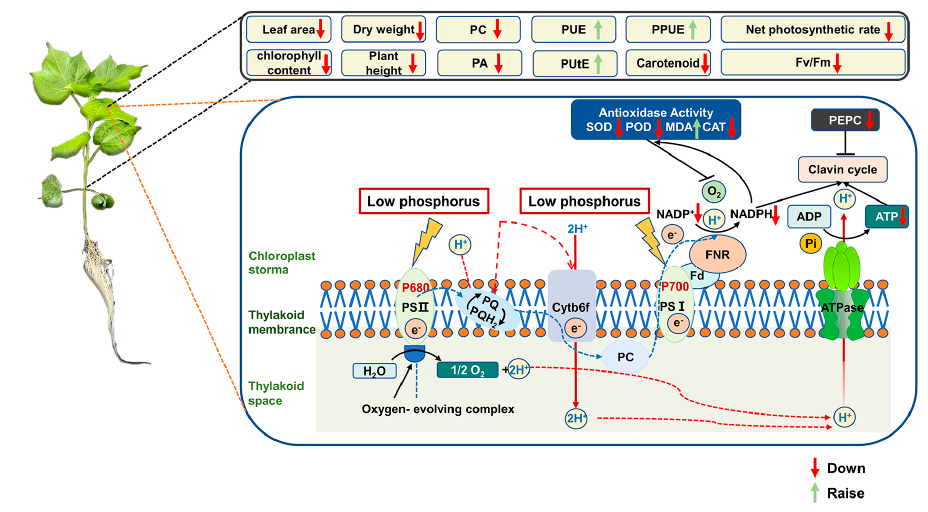
Figure 9. Pictorial representations of photosynthetic-electron-transport changes and feedback mechanisms responsible for low P availability. Processes that appear to be down-regulated are indicated by red arrows, while green arrows indicate processes that appear to be up-regulated. Unit size and font size represent the activities of the organelle components.